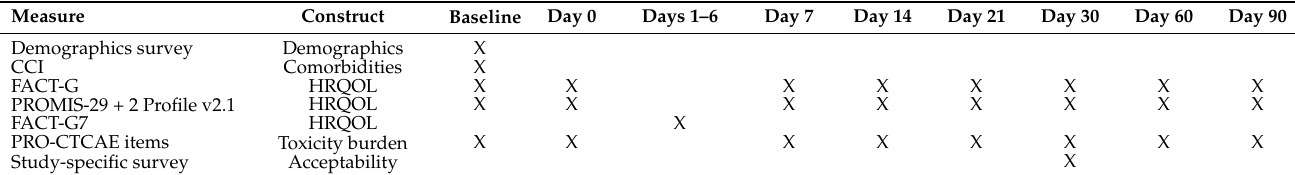
Table 1. Schedule and content of PRO